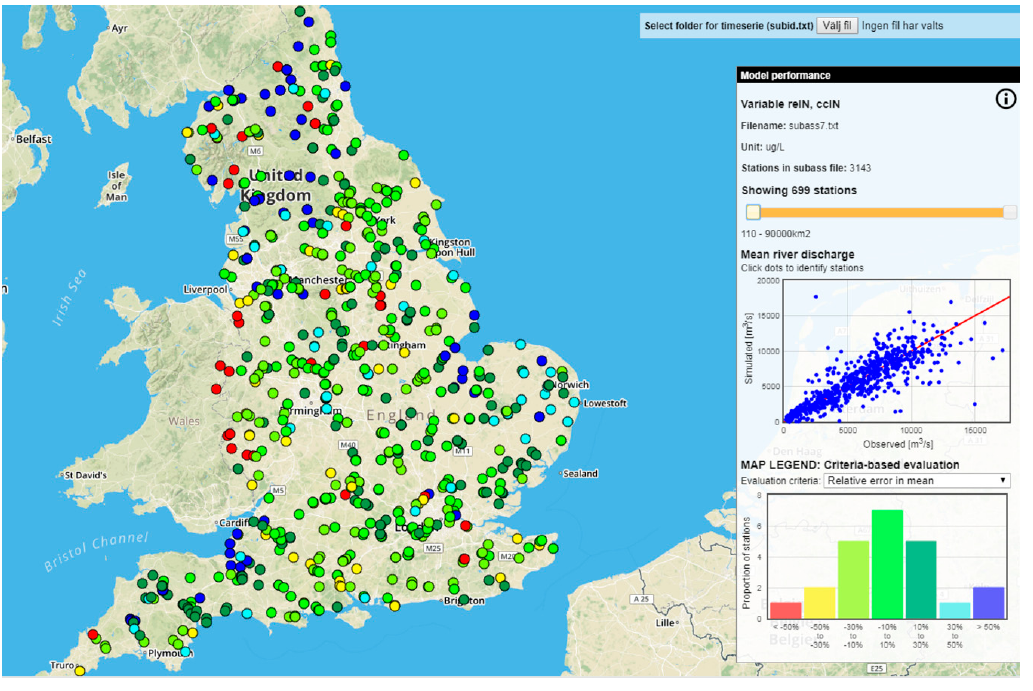
Figure 3. National performance for inorganic nitrogen (IN) using a flow weighted performance measure for catchments > 110 km 2 .